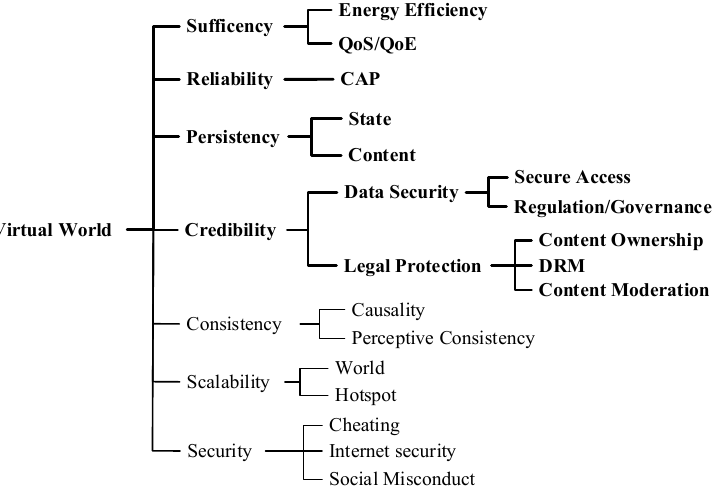
Figure 7. Taxonomy of design requirements and issues.